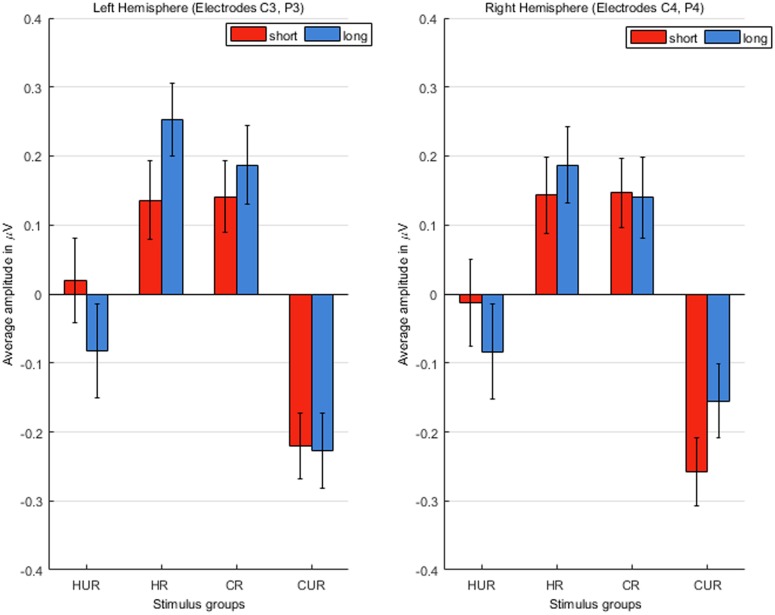
Means and standard errors of N400 amplitudes in laterally (C3, P3, C4, P4) located electrode pairs.